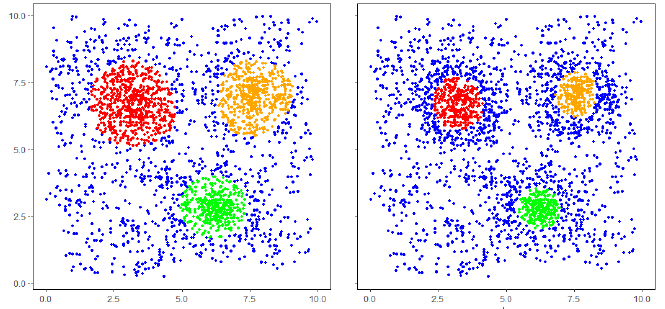
Figure 5. The inverse nature of the dependence of the first stage of SDPS on the center parameter. For ¯ p > p , the result of SDPS ( α , r , ¯ p )( X ) ( b ) was more rigorous than the result of SDPS ( α , r , p )( X ) ( a ) on array X (Figure